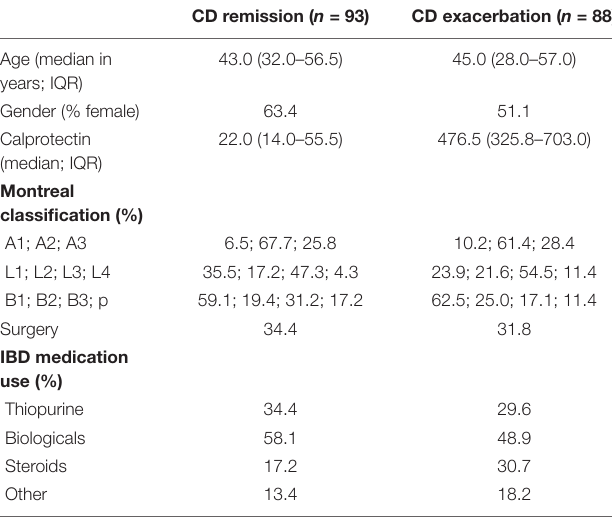
TABLE 1 | Baseline characteristics of the CD patient